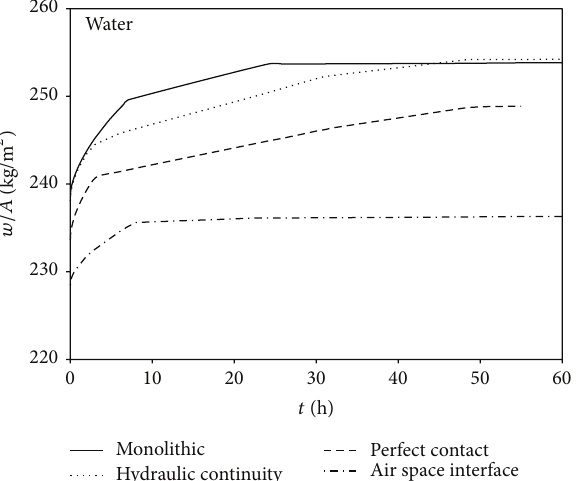
Figure 7: Effect of the different interfaces on the FLUMAX: monolithic specimens, hydraulic continuity interface, perfect contact interface, and air space